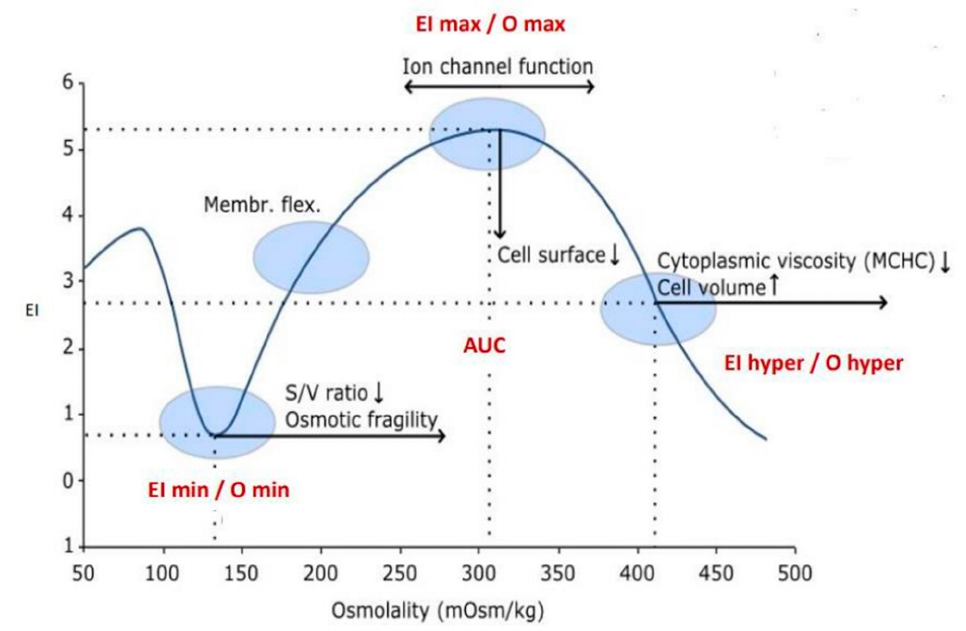
Figure 1. Osmotic gradient ektacytometry (OGE) curve provides information on RBC deformabiliy (EI), osmotic fragility (Omin) and cell hydration (Ohyper). EI values and the membrane rigidity are depending on the RBCs shape and their position along the osmolality axis.